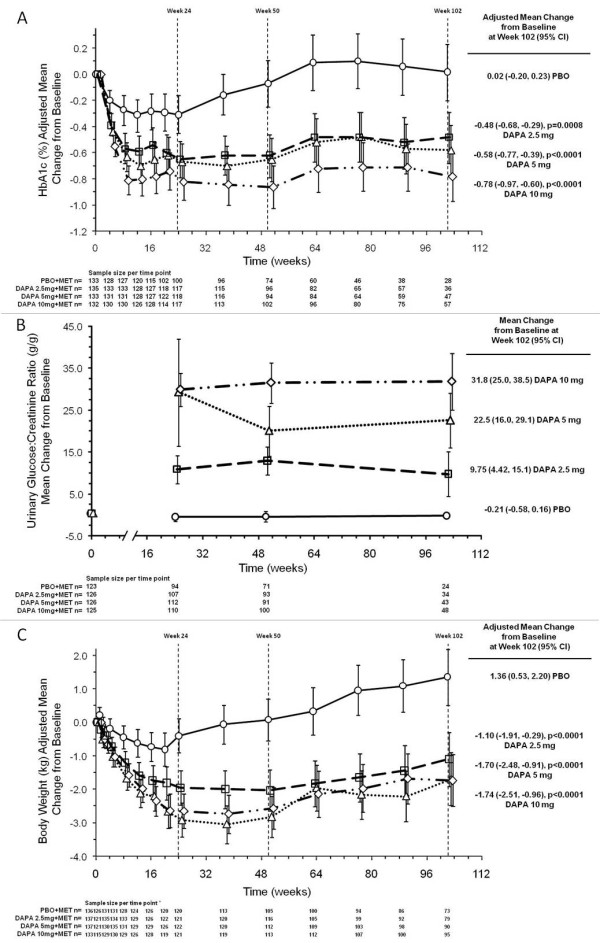
Change from baseline in (A) glycated hemoglobin (HbA1c), (B) urinary glucose:creatinine ratio, and (C) body weight for placebo (circles), dapagliflozin 2.5 mg (squares), dapagliflozin 5 mg (triangles), and dapagliflozin 10 mg (diamonds) groups all plus metformin up to 102 weeks. Data are means (95% CI) obtained from longitudinal repeated measures analyses. Data for HbA1c exclude patients who received rescue therapy to achieve the strict HbA1c requirements to remain in the trial. The urinary glucose:creatinine ratios also exclude patients who received rescue therapy. Data for weight, however, include patients who received rescue therapy (pioglitazone), demonstrating the ability of dapagliflozin to attenuate weight gain by this antidiabetes medication. Mean change from baseline in HbA1c after adjustment for baseline value (A), mean change from baseline in urinary glucose:creatinine ratio (g/g) after adjustment for baseline value (B) and mean change from baseline in body weight after adjustment for baseline value (C) are shown.